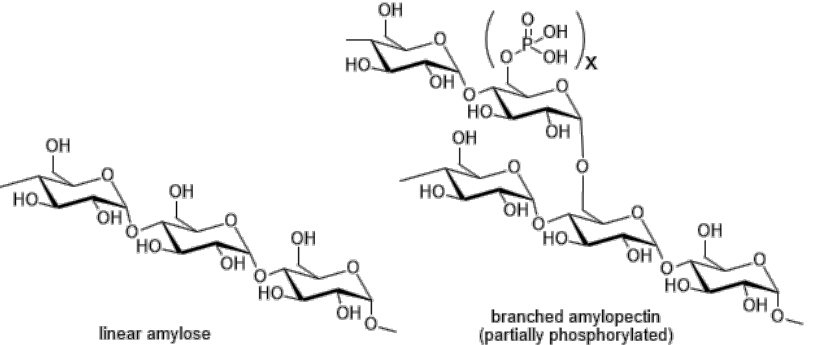
Figure 5. Specific structural features of polycarbohydrates, which may vary in starches of different potato